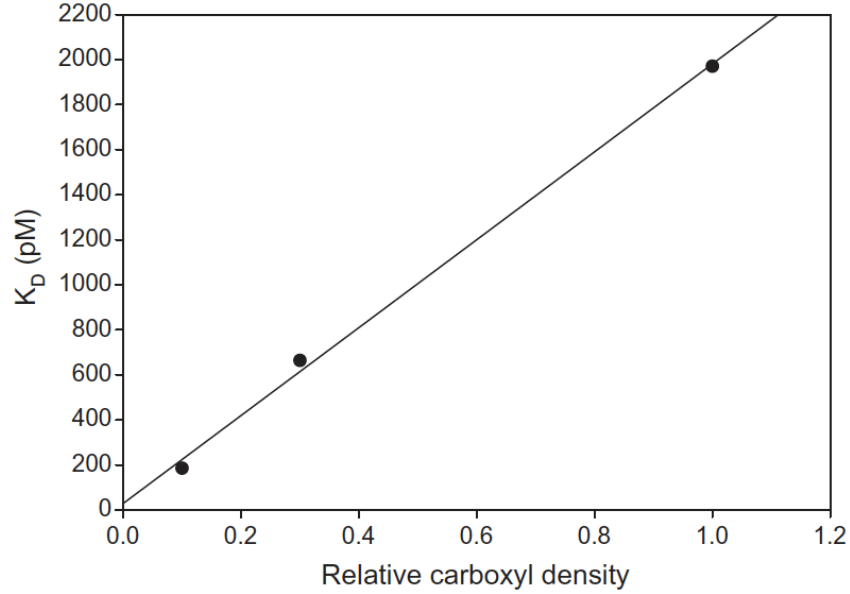
Figure 2. The effect of CM-dextran density on mAb/Ag affinity measurements. Reproduced with permission from [26]. Copyright 2012 Copyright